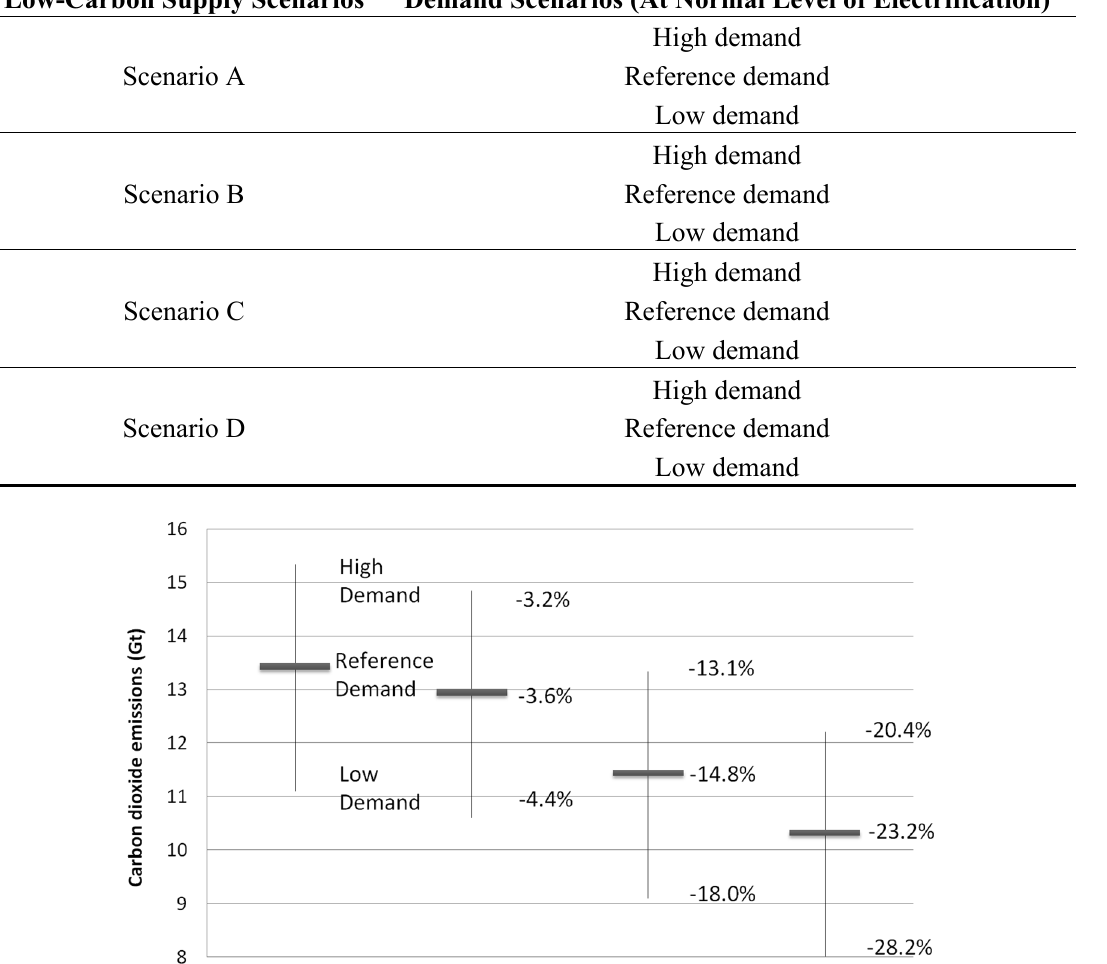
Figure 8. Emissions reduction with increasing low-carbon technology capacity under different demand trends by